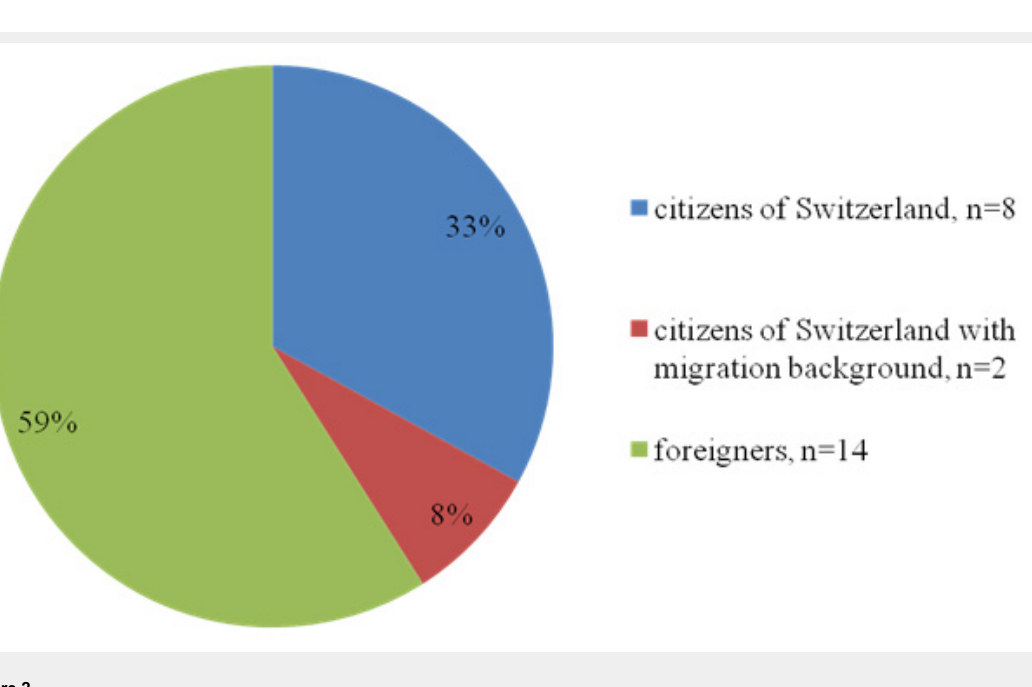
Origin of the participating patients. Of the study population 59% (n = 14) were foreigners (i.e., not citizens of Switzerland), 33%, (n = 8) were Swiss, two citizens of Switzerland (8%) had a migration